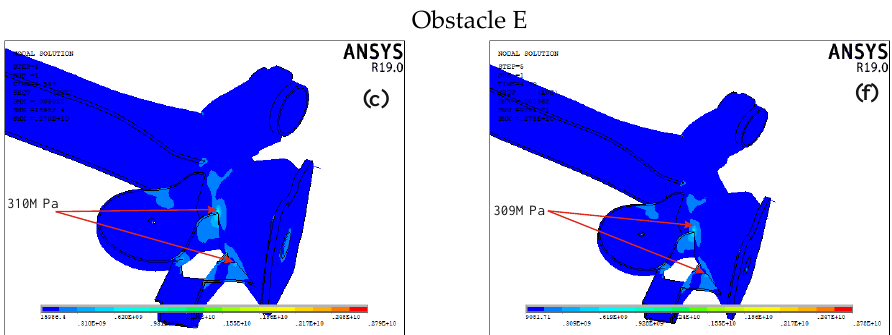
Figure 16. Contour plot of the reduced stresses obtained during overcoming an obstacle at velocity υ = 30 kmh − 1 . ( a ) without motors in wheels and before obstactle, ( b ) without motors in wheels and obstactle U, ( c ) without motors in wheels and obstactle E, ( d ) with motors in wheels and before obstactle, ( e ) with motors in wheels and obstactle U, ( f ) with motors in wheels and obstactle E.